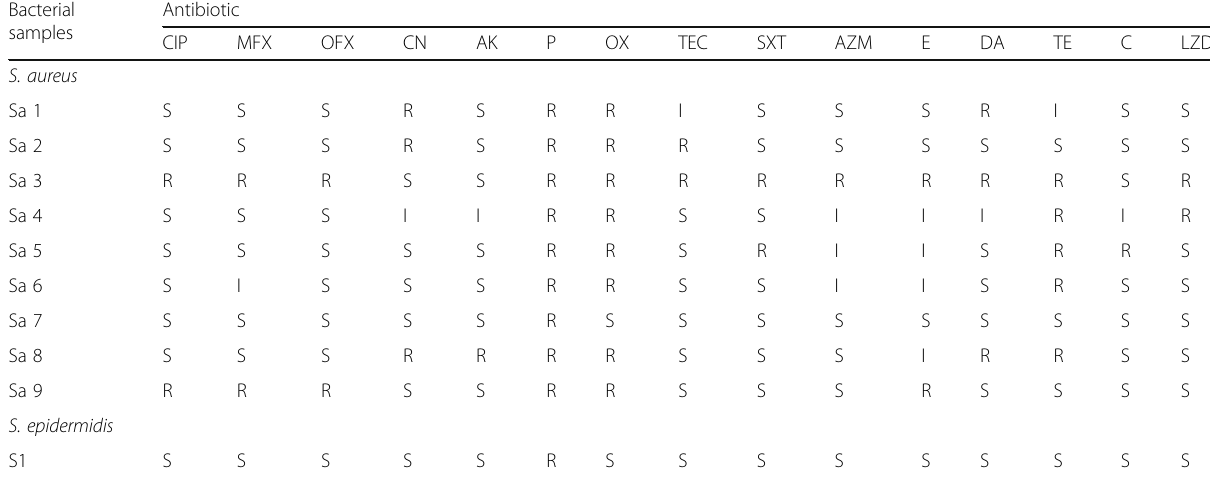
Table 4 Susceptibility test of the studied Staphylococcus spp. isolates against standard antibiotics Bacterial samples